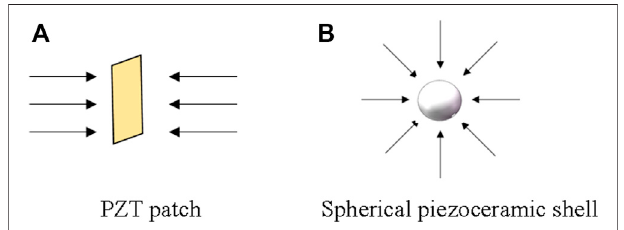
FIGURE1| PrincipleofreceivingsignalsfromdifferentPZTelements. (A) PZT patch. (B) Spherical piezoceramic shell.